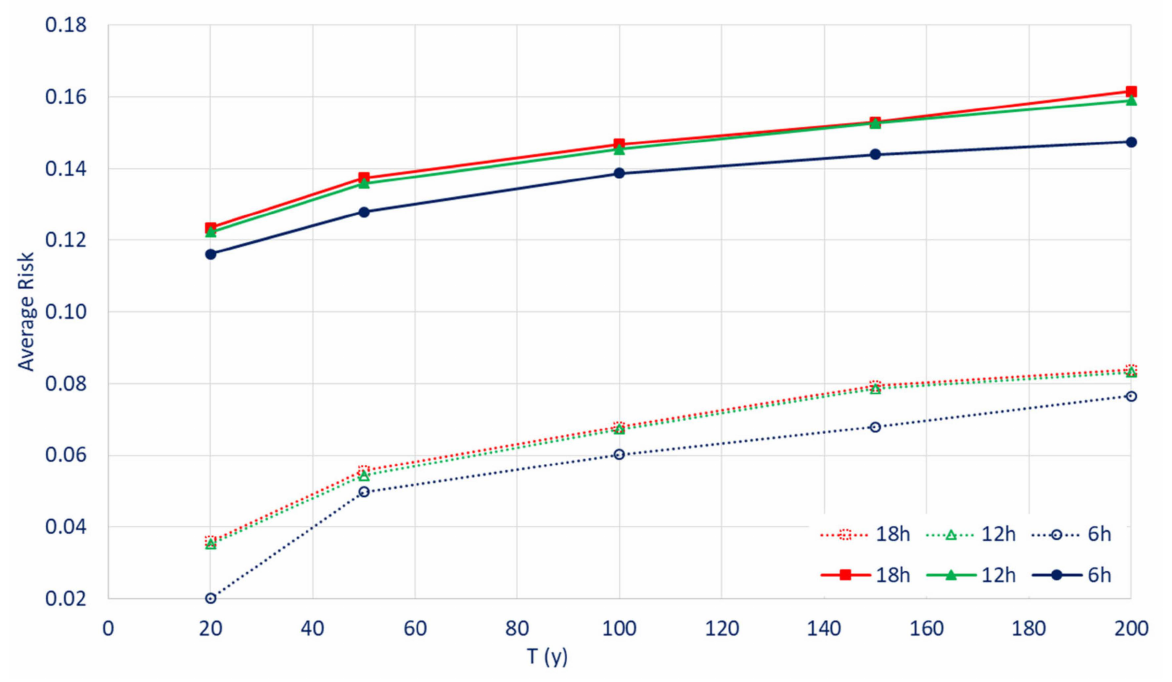
Figure 15. Relationship between the average risk and the flood return period (dotted lines represent scenarios with flood protection works).